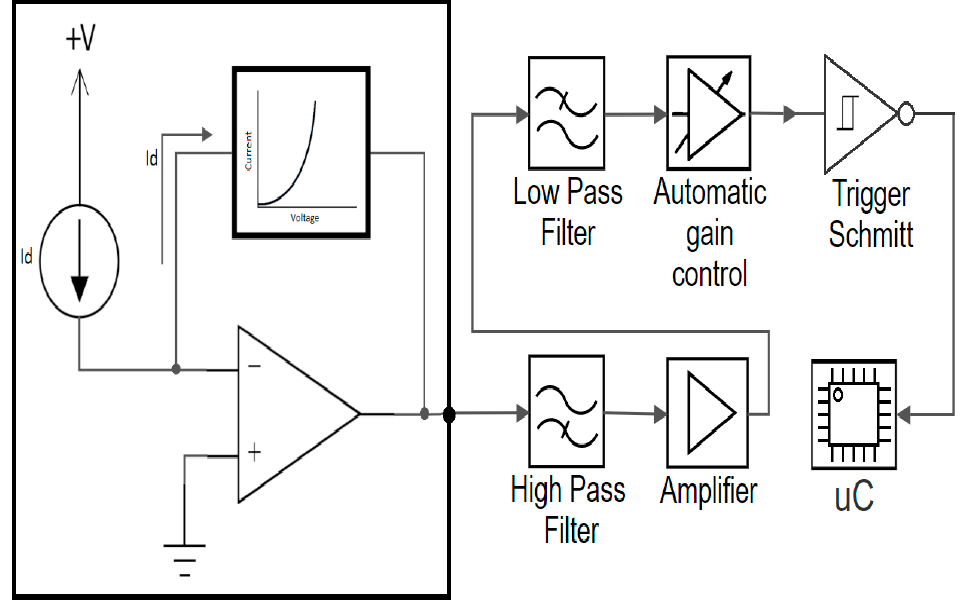
Figure 1. Schematic design of the VLC sensor, emphasizing the logarithmic transimpedance behavior. It is well known that in VLC the background light represents the most important disturbing element. The light is fluctuating in time and in space, whereas its irradiance can range from few µ W / cm 2 to more than 100.000 µ W / cm 2 . Thus, the di ff erence between the minimum value and the maximum value can expand on five decades. Consequently, selecting the working range of the transimpedance circuit can be di ffi cult. Insu ffi cient sensibility can lead to circuit blockage and reduced communication ranges, whereas too much sensitivity can lead to photosensitive element saturation [2].